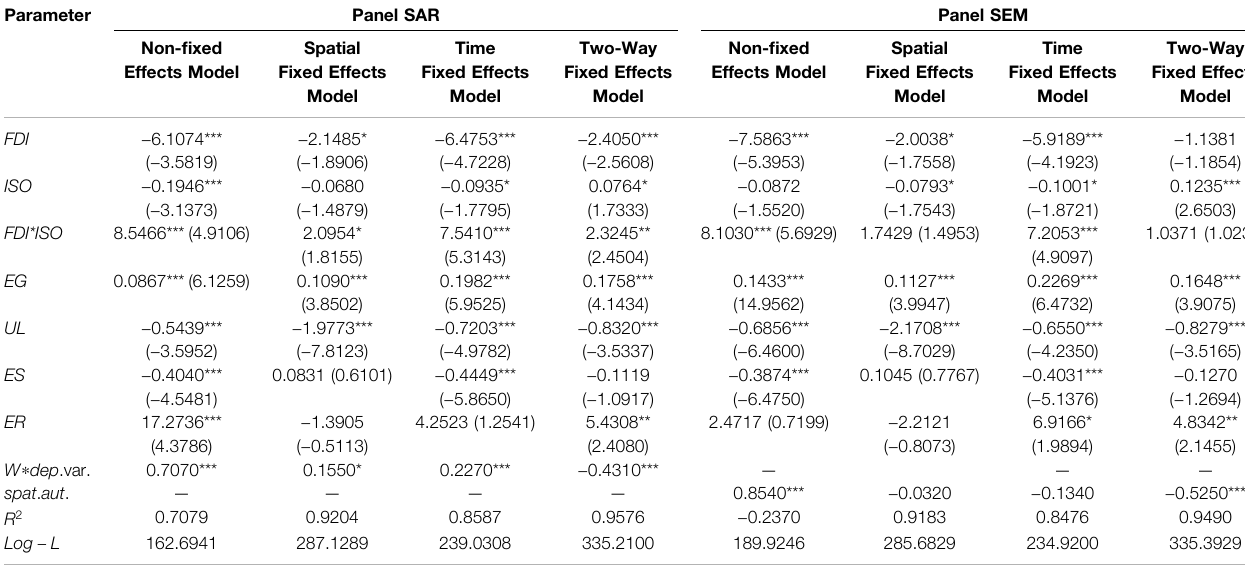
TABLE 6 | Estimation results of spatial measurement models.